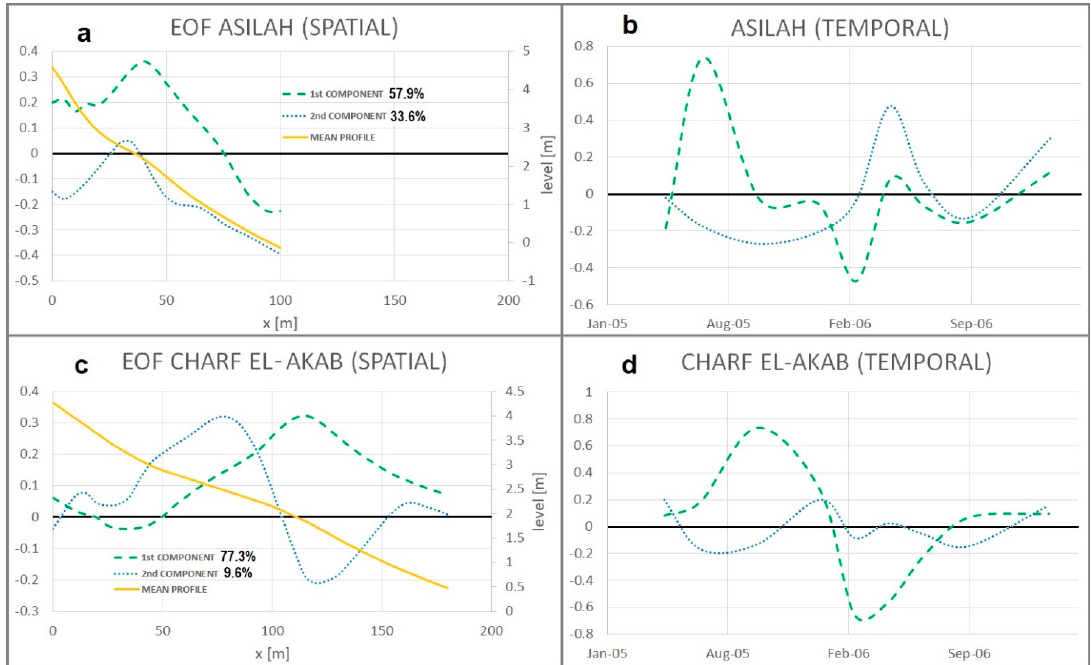
Figure 6. ( a ) Spatial EOF in Asilah (RF); ( b ) temporal EOF in Asilah (RF); ( c ) spatial EOF in Charf el-Akab (SR); ( d ) temporal EOF in Charf el-Akab (SR). The height of the mean profile is reported on the vertical axes. The percentages of variance described by the components are reported in the legends.